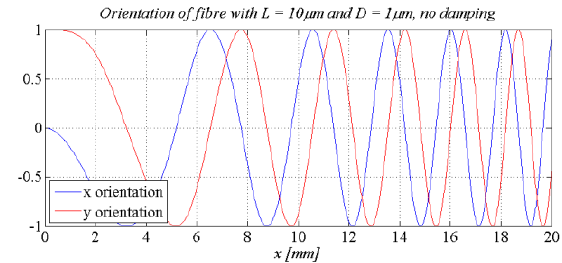
Fig. 7. Components of orientation of a fibre with no damping